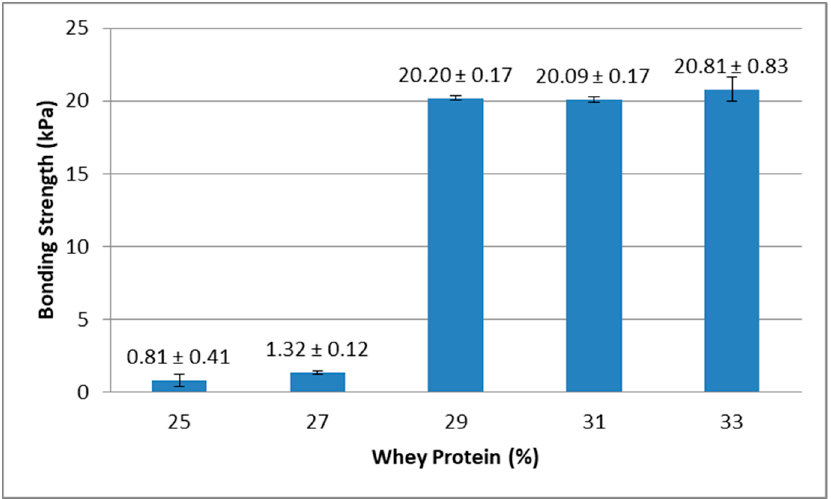
Figure 4. E ff ect of whey protein concentration on bonding strength (glutaraldehyde (GTA) at 14%).